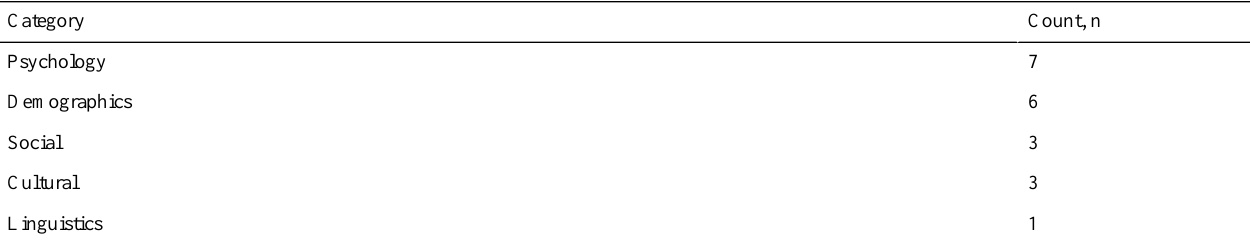
Table 4. Categories of the studies identified.